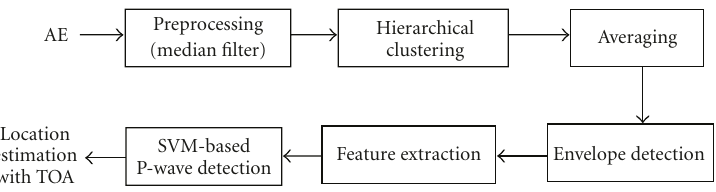
Figure 1: Schematic diagram of the signal processing and classification system. The AE signals were preprocessed with a median filter. In the following step they are grouped with a hierarchical clustering procedure. An averaging step was implemented in each cluster to improve the SNR. This is followed by a feature extraction procedure in time and frequency domains. On the test data, the feature extraction and classification steps were executed when the signal envelope exceeded a predefined threshold. The TOA is calculated by detecting the P-waves with an SVM classifier.